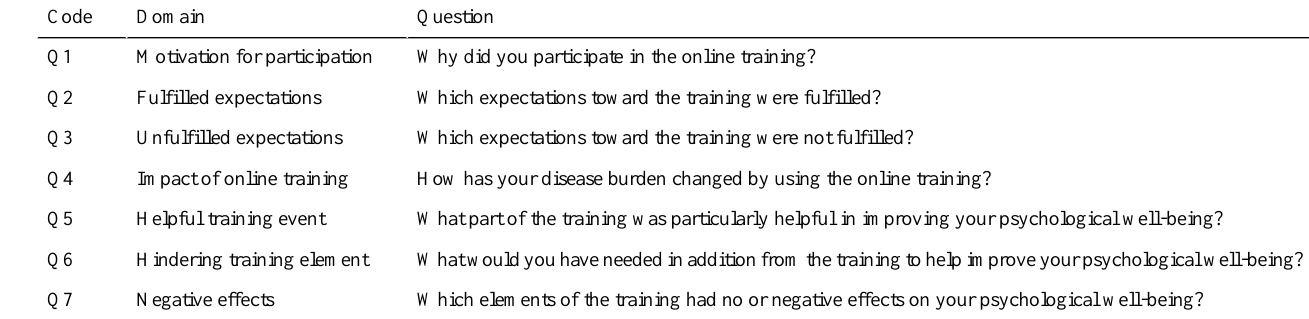
Table 1. Overview of interview questions and